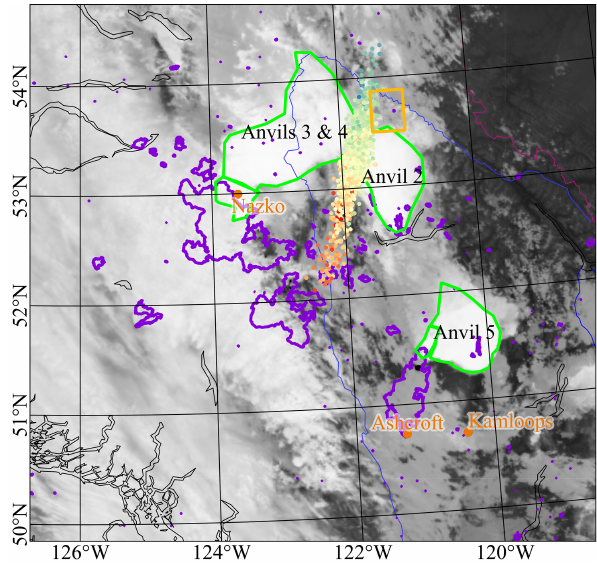
Figure 12. Map of the source region, showing the areas that burned in 2017 (purple; some areas are sufficiently small that the contours enclosing them appear as dots) and anvils observed in AVHRR data (green). The anvils are numbered using the same scheme as Pe- terson et al. (2018); their anvil 1 is outside the area shown here. The greyscale backdrop is the AVHRR channel 5 (thermal IR) im- age taken at about 02:00GMT. The orange rectangle shows the size and shape in the horizontal of the cuboid release volume. The small points are the MCMC solutions for the apparent origin of the pol- luted air mass and are coloured according to time, varying from 02:00GMT on 13 August 2017 (red) to 07:30GMT (blue).